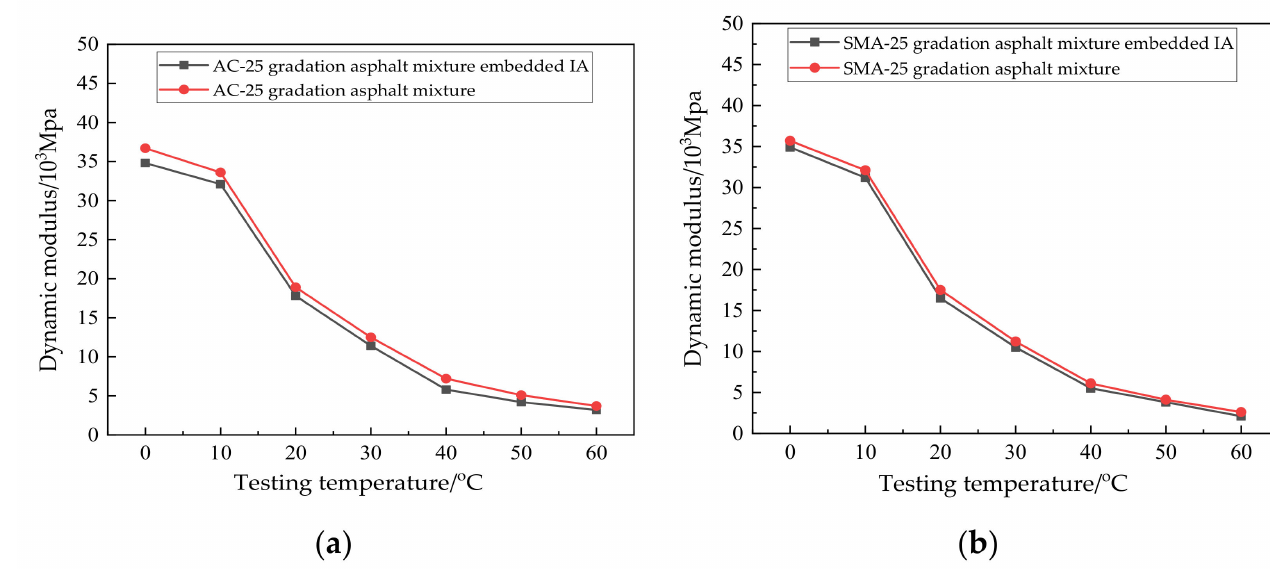
Figure 9. Comparison of the dynamic modulus test results. ( a ) AC-25 gradation; ( b ) SMA-25